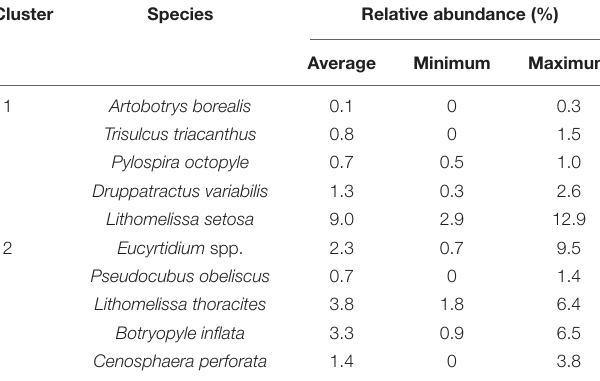
TABLE 1 | The top five species that contribute each cluster of the Southern Ocean Multivariate Regression Tress analysis, and their average, maximum, and minimum relative abundance across all sites that occur in the cluster.